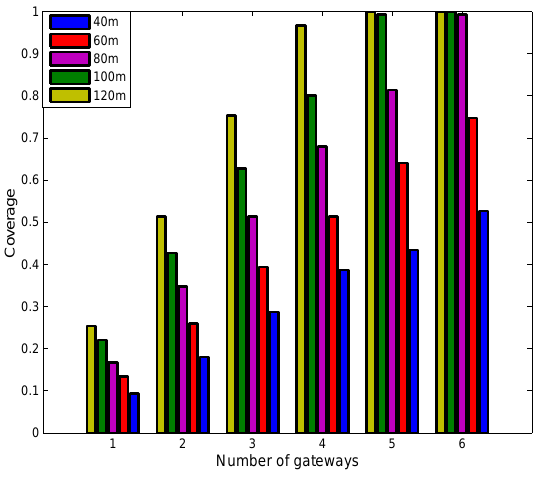
Figure 6. Impact of transmission